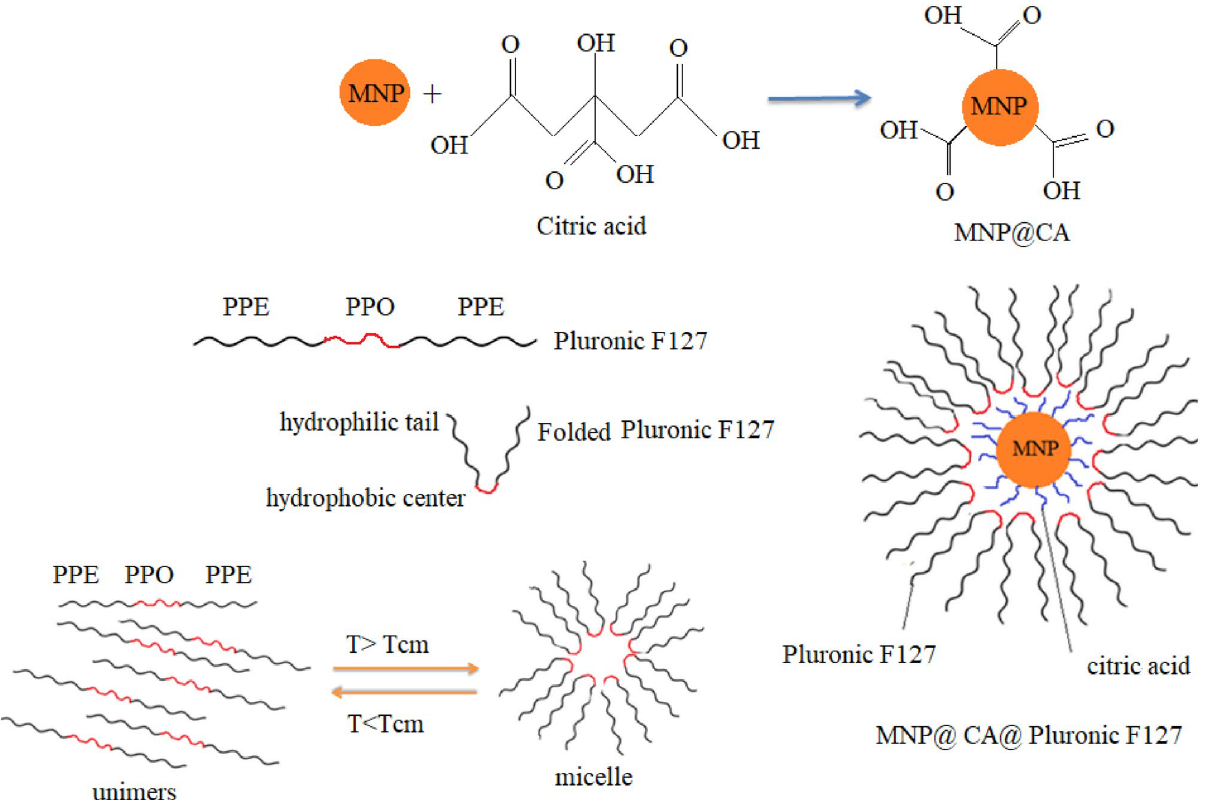
Figure 2. Schematic illustration of the coating process applied to the nanoparticles.